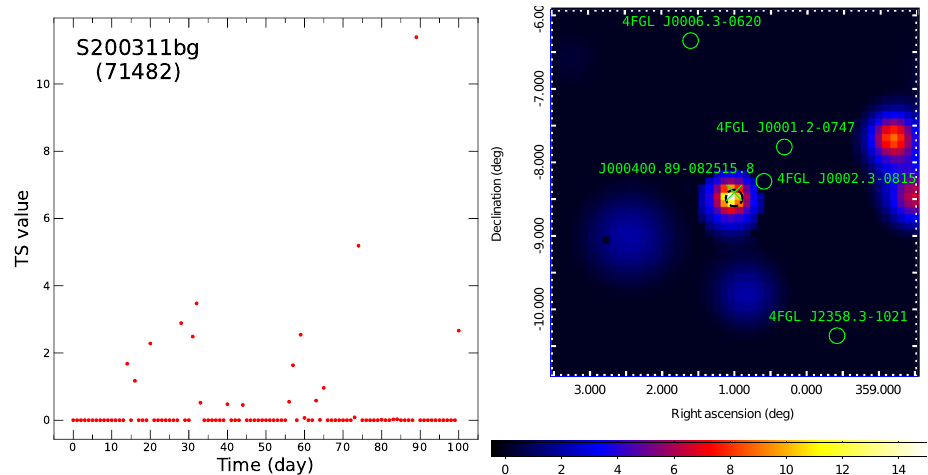
Figure 1. ( Left ) TS curve with 1-day time bin from − 1 to 100 days of the BBH merger trigger S200311bg for J000400.89 − 082515.8 (71482). A TS (cid:39) 11 data point is seen at 88 days. ( Right ) 0.3–500 GeV TS map with a size of 5 ◦ × 5 ◦ for the high-TS data point. The 4FGL sources in the field are marked with circles. The position of the target galaxy is marked with a cross, while a dashed black circle is the 2- σ error circle (radius 0.11deg) determined for the candidate γ -ray